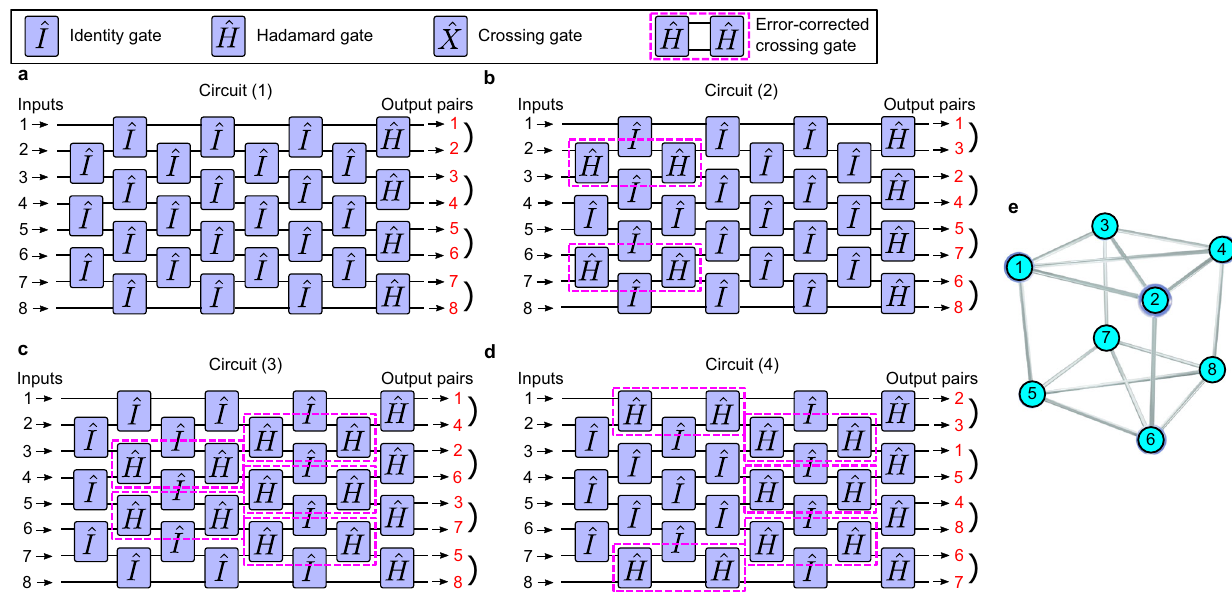
Fig. 3 Optically-heralded quantum entanglement (OHQE) circuit con fi gurations. a – d OHQE circuit diagrams labeled (1) – (4) with error- corrected crossing gates for the four circuits. Each circuit routes a pair of inputs to the output Hadamard gates, enabling photon-mediated quantum entanglement protocols. e Connectivity generated between the 8 inputs using circuits (1) – (4), forming a cubic lattice unit cell. Connections between inputs (1,4), (2,3), (5,8), and (6,7) are optional for the purposes of generating the unit